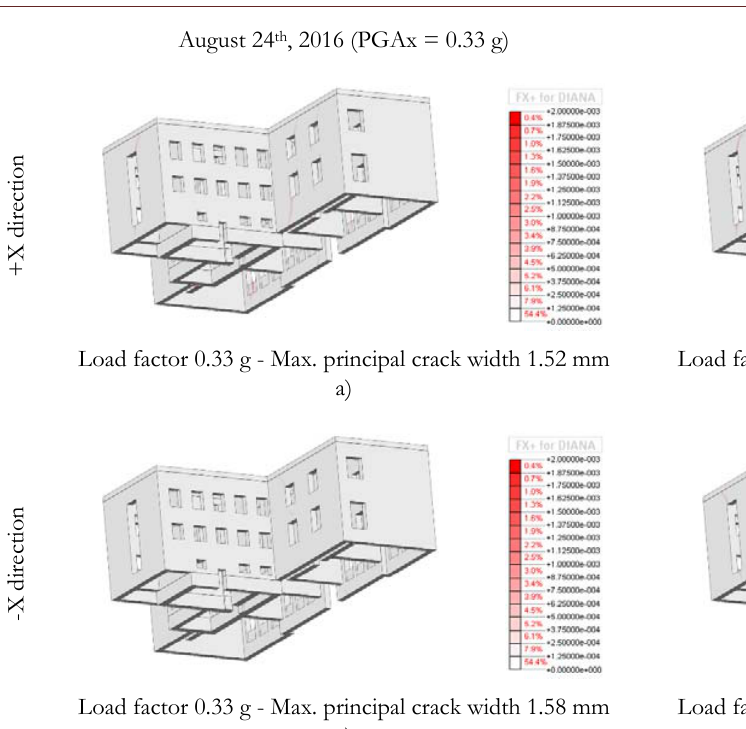
Figure 16: Principal crack width for horizontal load factors comparable to the PGA recorded in the X direction of the building in the seismic events of August 24 th , 2016 (left) and October 26 th , 2016 (right): a)-b) +X direction, c)-d) -X direction.